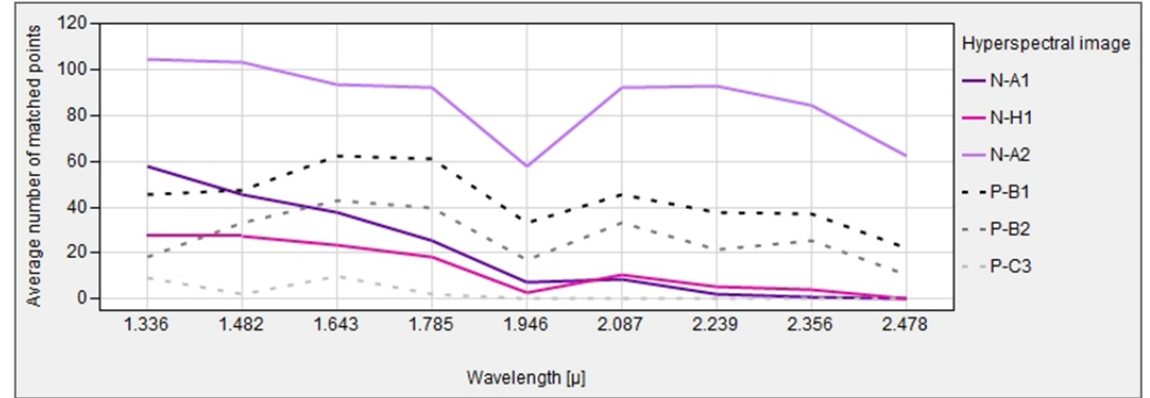
Figure 8. Average (from all the tested parameter configurations) number of points matched per single hyperspectral band depending on the band